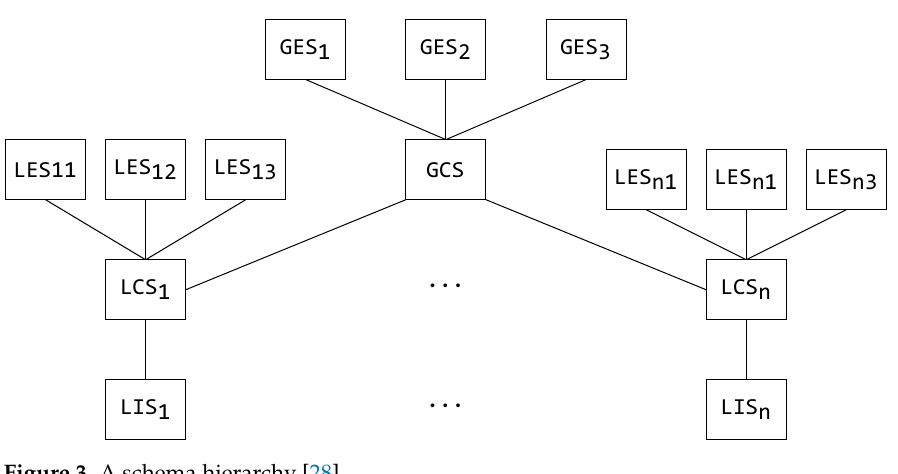
Figure 3. A schema hierarchy